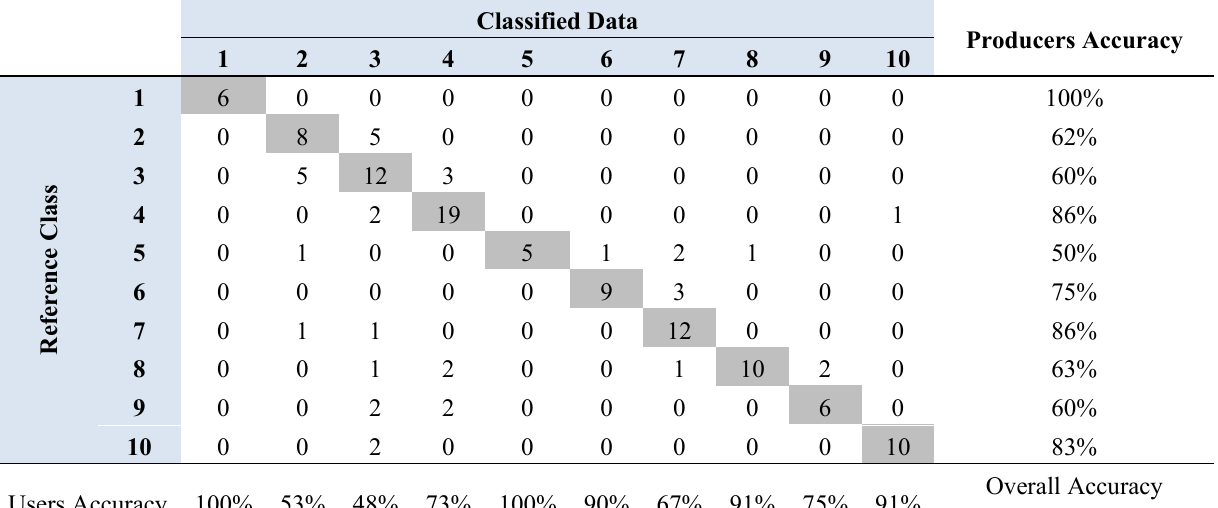
Table 8. Confusion matrix for RFE classification with RBF-kernel ( C = 4, g =